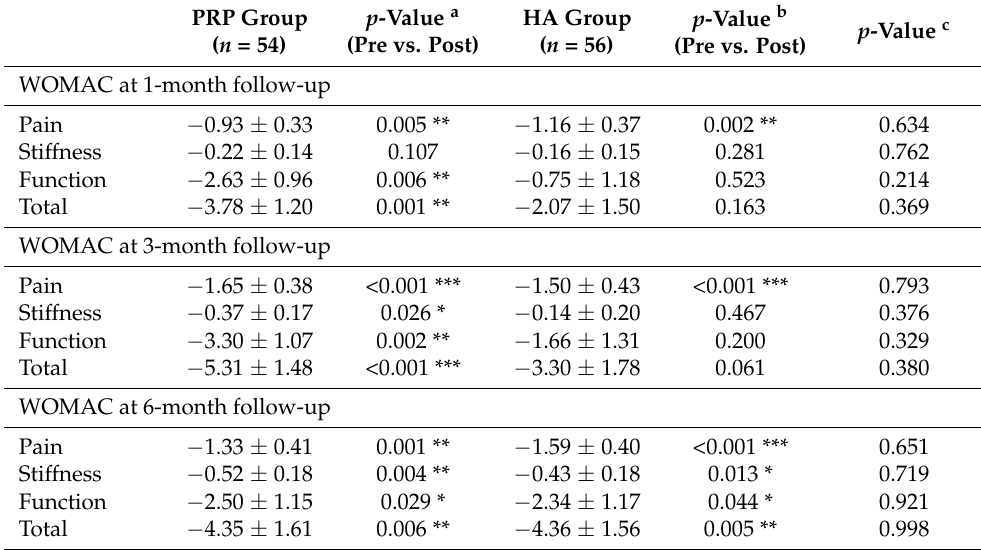
Table 3. Changes in WOMAC scores from baseline to follow-up visits in the two treatment